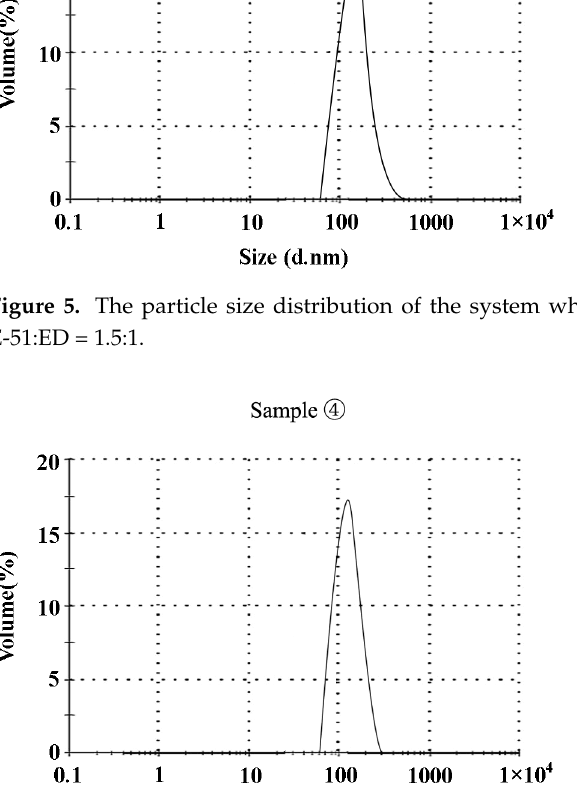
Figure 6. The particle size distribution of the system when the molar ratio of epoxy groups is E51:ED = 1:1.